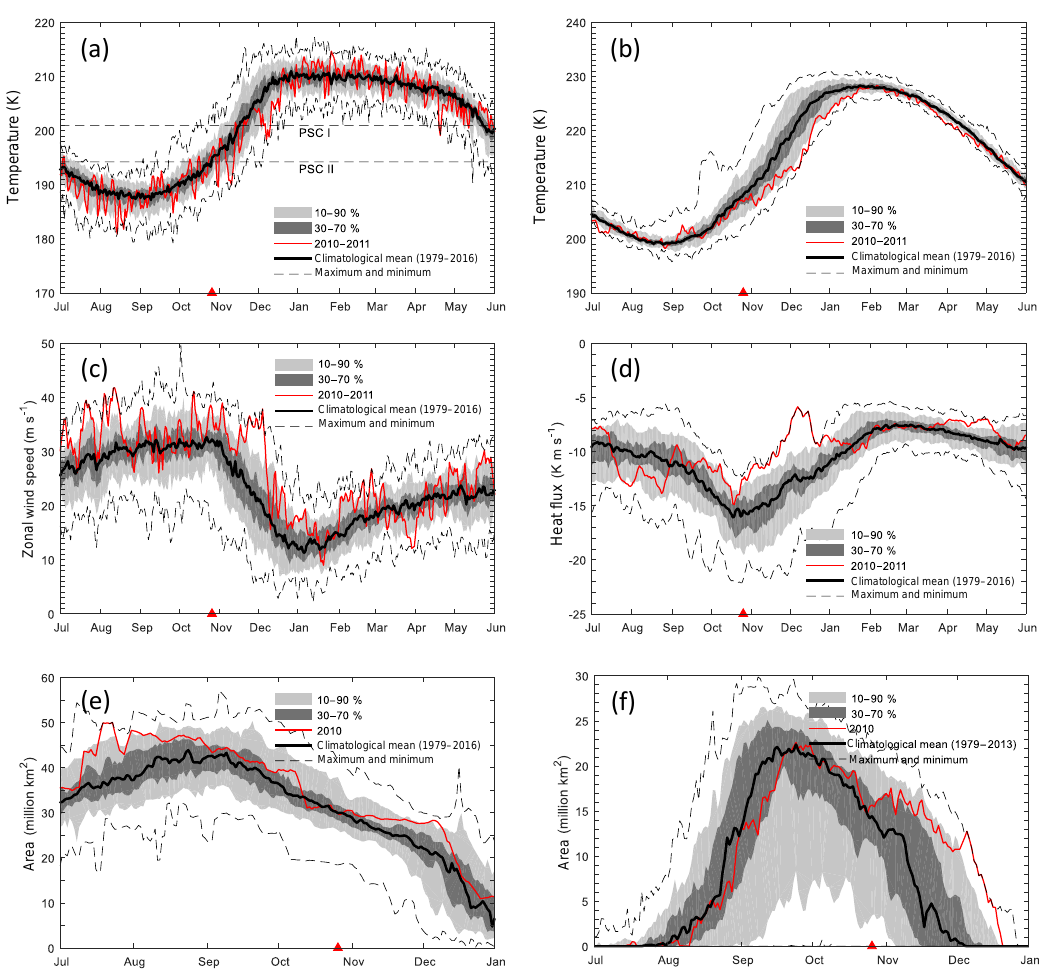
Figure 1. (a) Minimum temperature south of 50 ◦ S at 150hPa; (b) temperature averaged over the polar cap for latitudes south of 60 ◦ S at 150hPa; (c) zonal wind speed at 60 ◦ S at 150hPa; (d) eddy heat flux averaged between 45 ◦ S and 75 ◦ S for the 45-day period prior to the date indicated at 150hPa; (e) the area of the polar vortex for 1 July–31 December 2010 on the 460K isentropic surface; (f) ozone hole area for 1 July–31 December 2010. Temperatures for PSC existence in (a) are determined by assuming a nitric acid concentration of 6ppbv and a water vapor concentration of 4.5ppmv. Panels (a) – (f) are based on Modern-Era Retrospective analysis for Research and Applications reanalysis version 2 (MERRA2) data (Bosilovich et al., 2015). The ozone hole area in (f) is determined from OMI ozone satellite measurements (Levelt et al., 2006). The red triangles indicate the time of the Merapi